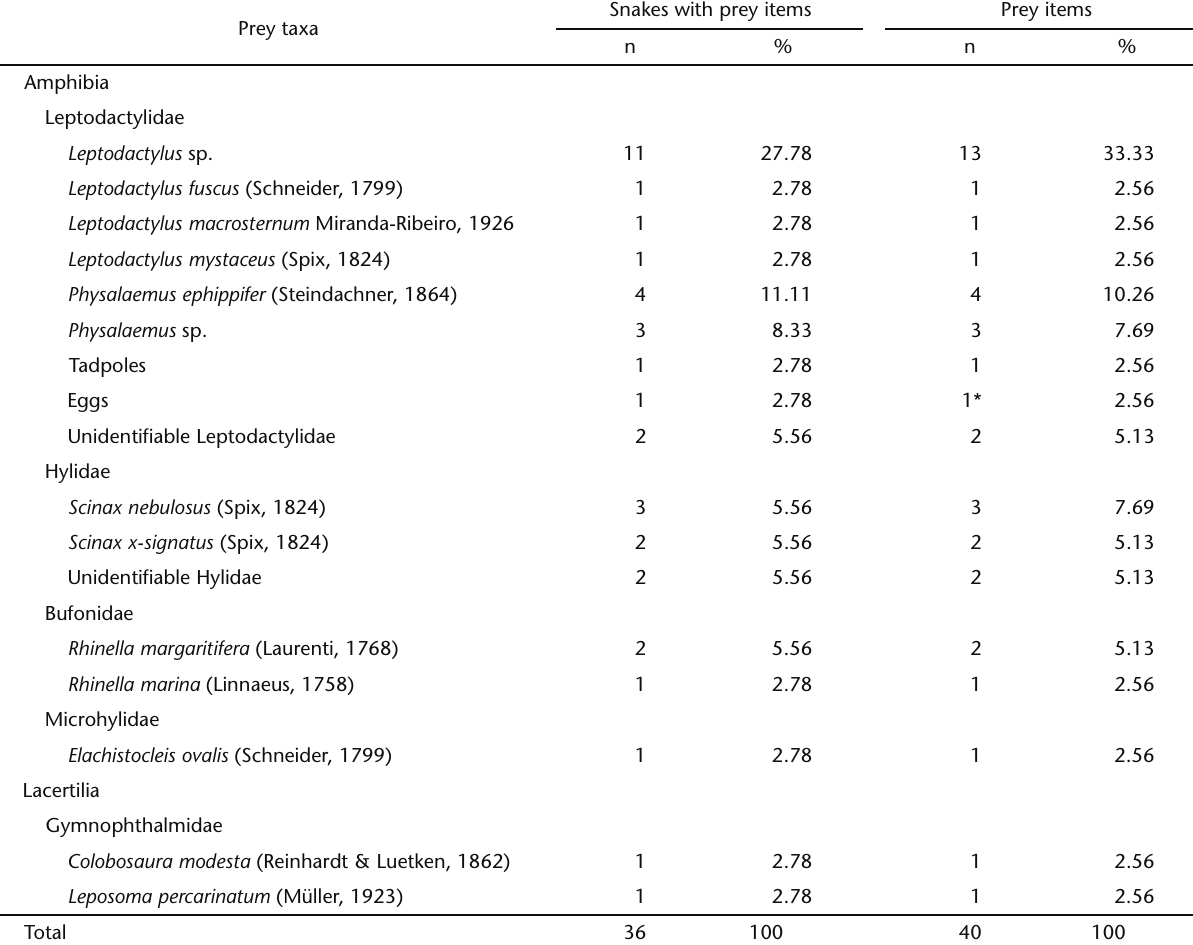
Table I. Food items and their frequency in the diet of L. reginae semilineatus from eastern Amazon, Pará. (*) The Leptodactylidae eggs (n = 128) were considered as a single food item. Snakes with prey items Prey items Prey taxa Amphibia